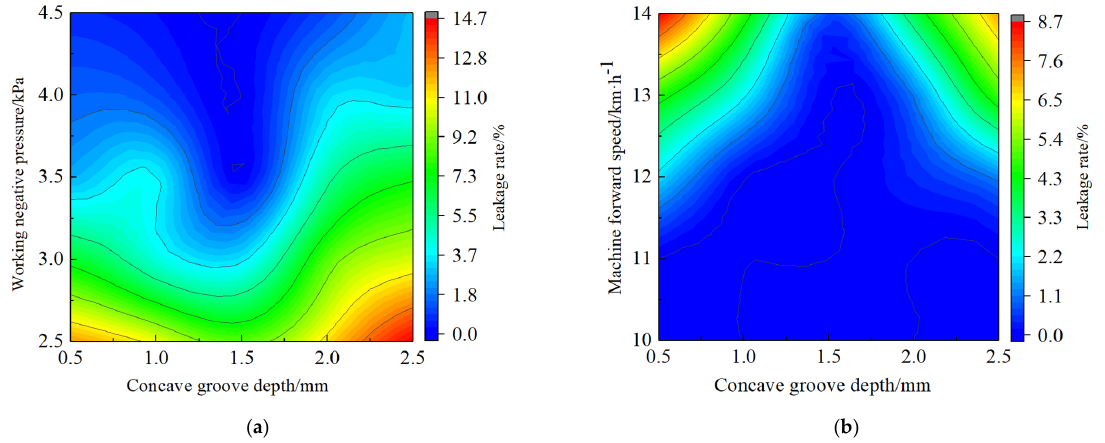
Figure 15. Influence of two-factor interaction on the leakage rate. ( a ) The machine’s forward speed is 12 km·h − 1 , ( b ) the working negative pressure is 4 kPa.